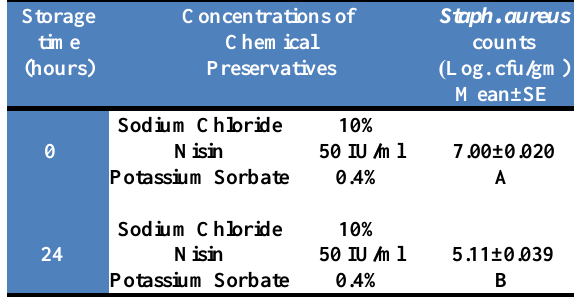
Table, 4: The combining antibacterial activities of Nisin and Potassium Sorbate against Staph. aureus in the experimentally manufactured soft cheese after 24 hrs. of storage inside the brine solution at 37 ˚ C